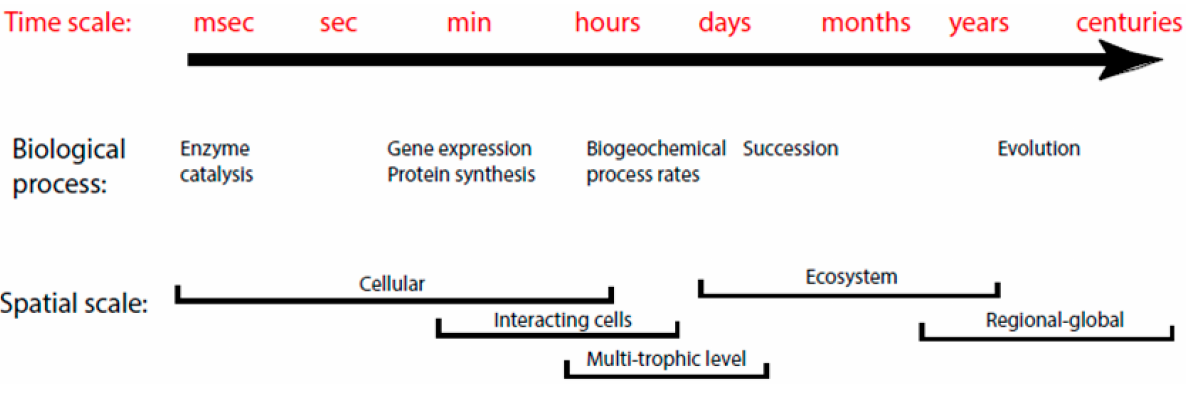
Figure 1. Characteristic time and length scales for various biological